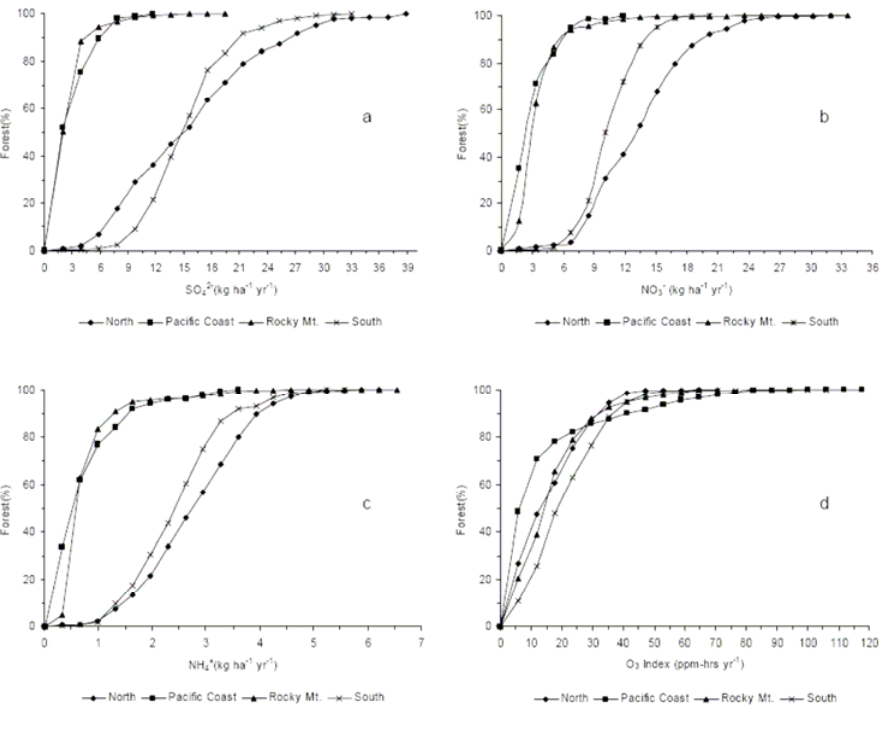
FIGURE 10 . Proportion of forests affected by air pollutants in the